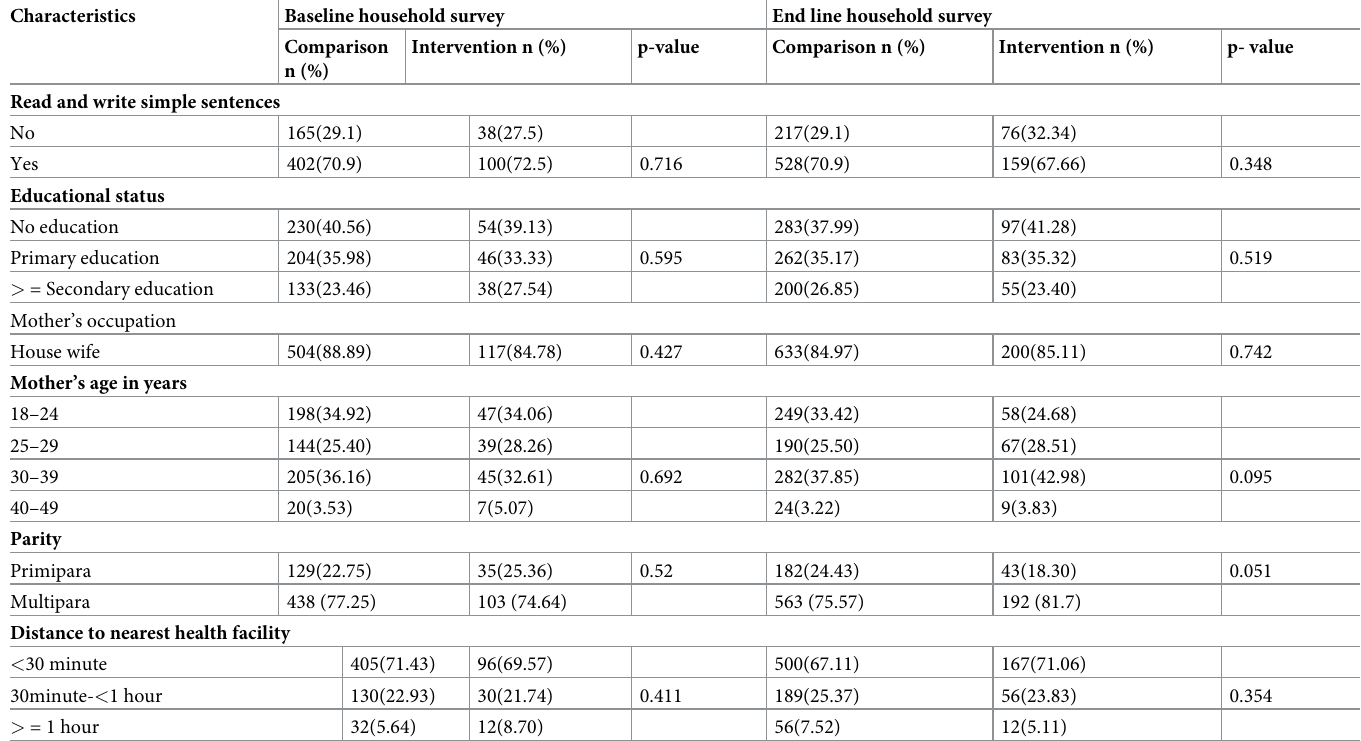
Table 1. Sociodemographic characteristics of participants at baseline and end line surveys in intervention and comparison areas.